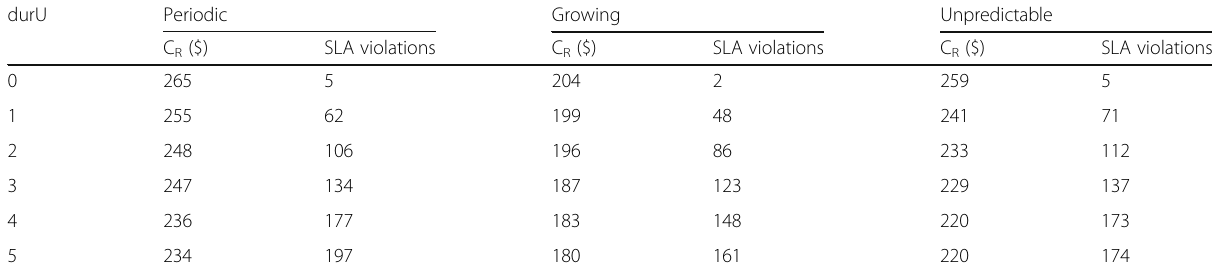
Table 9 Impact of increasing durU on the cost factors durU Periodic Growing Unpredictable